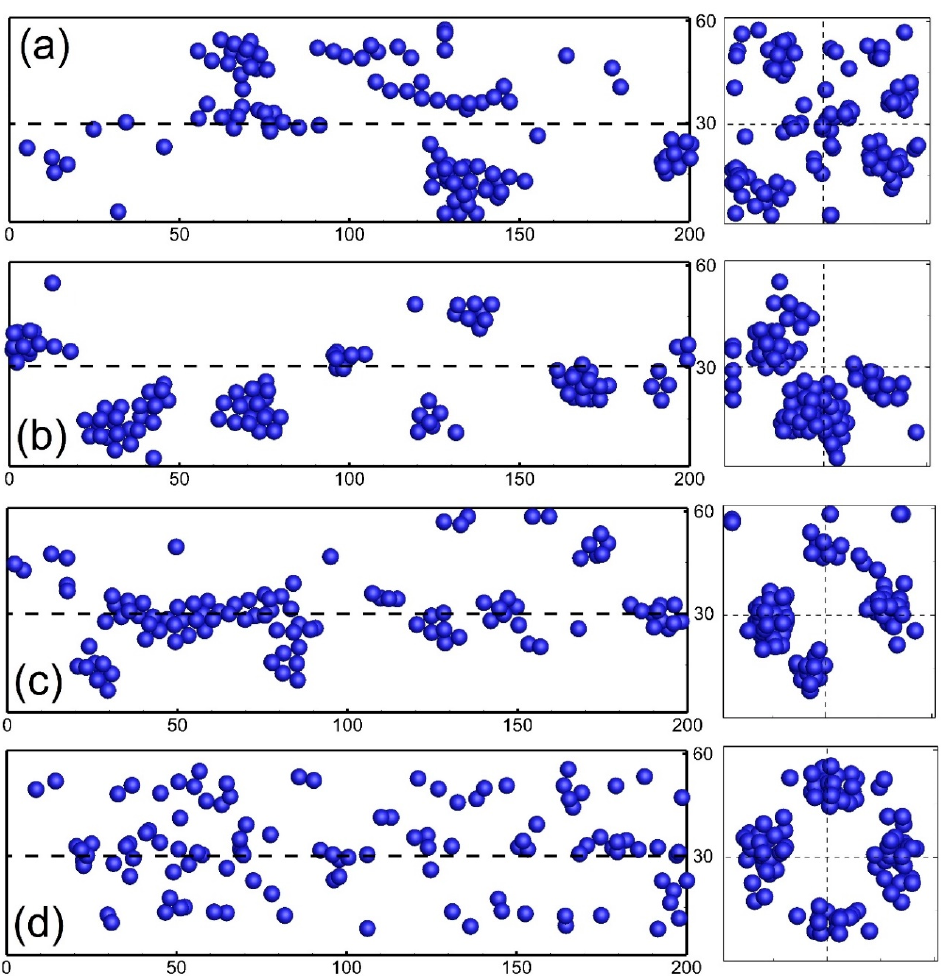
Figure 20. Snapshots of adhesive particle suspensions with γ = 0.0075 and different Reynolds numbers ( a ) Re = 5.4, ( b ) Re = 21.6, ( c ) Re = 54 and ( d ) Re = 108. The left columns are side views and the right columns are cross-sectional view.